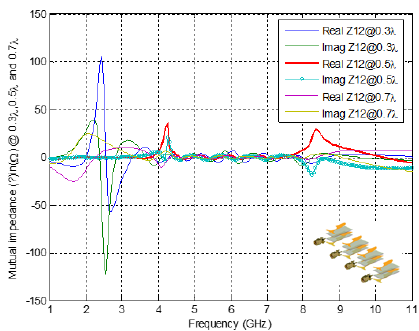
FIGURE 8. Mutual impedances Z 12 , Z 13 and Z 14